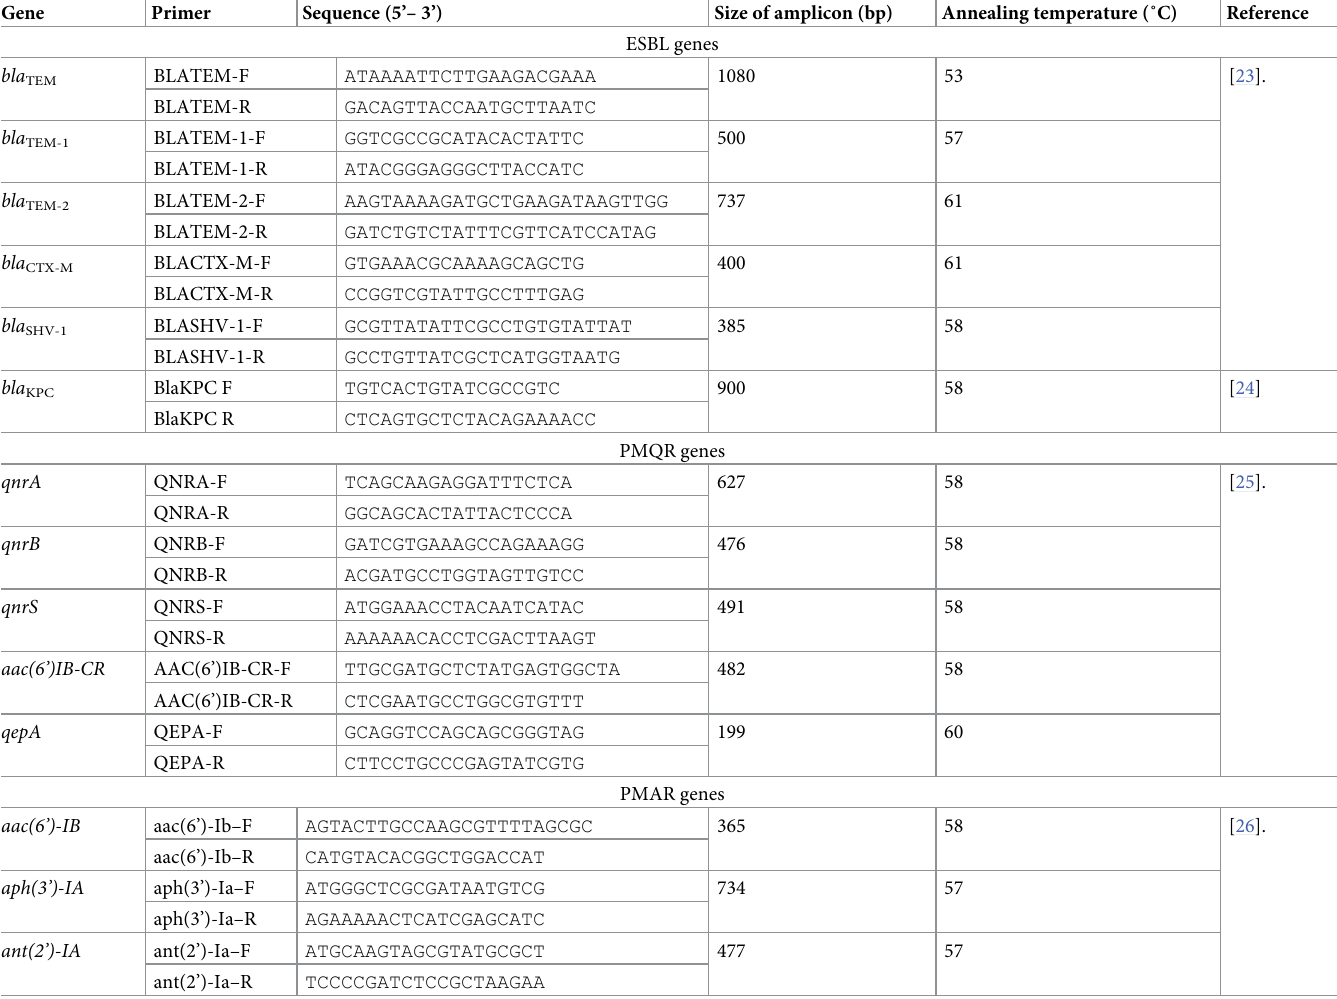
Table 3. Primers used for the amplification of resistance